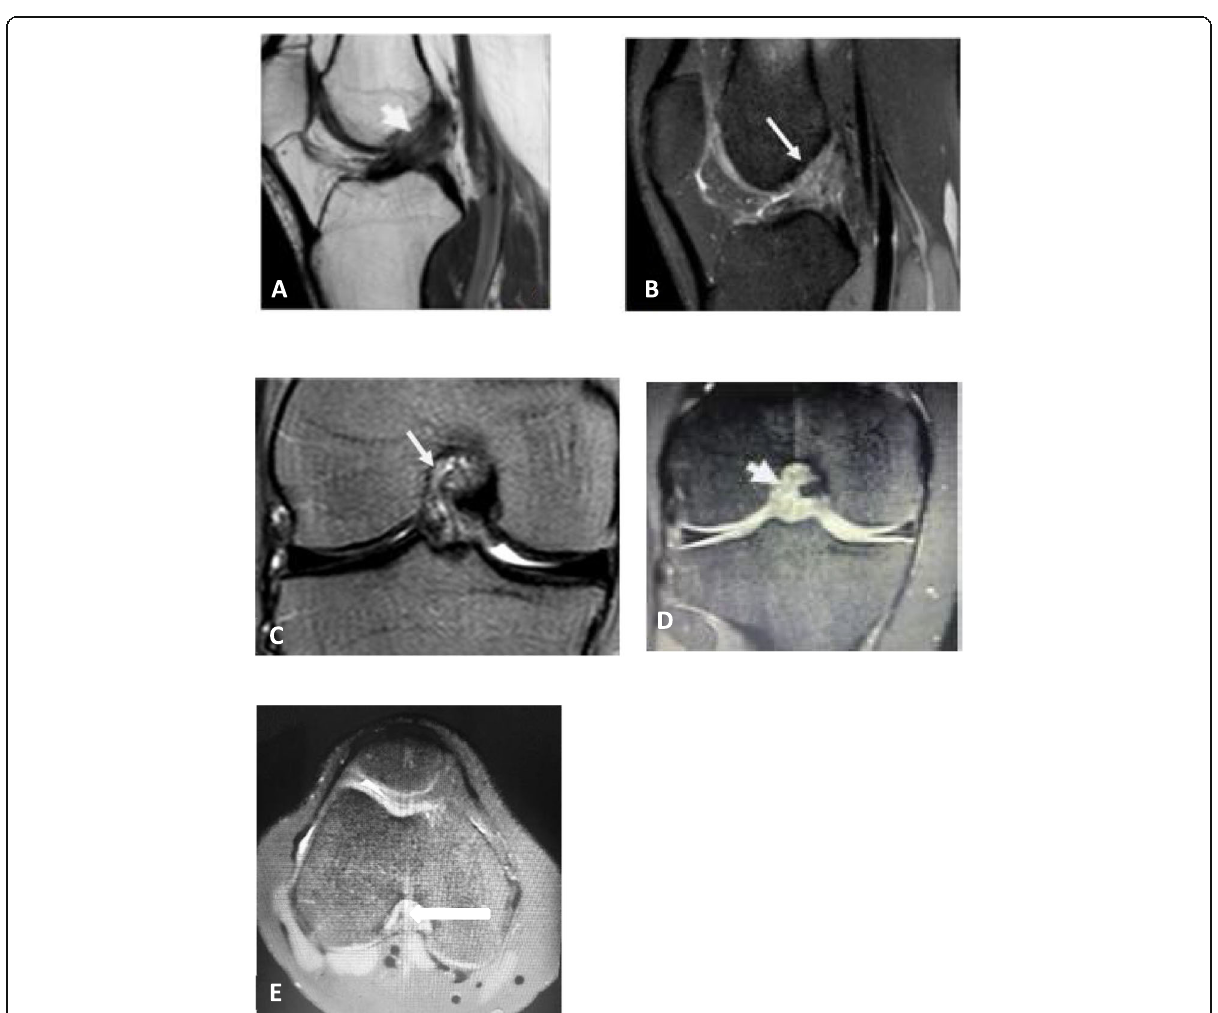
Fig. 6 A 19-year-old male patient presented by acute RT knee joint pain after trauma. a , b Sagittal Standard 2D T2WI and 3D MPR VISTA images. c , b Coronal standard 2D T2 and 3D MPR VISTA images. e Axial MPR VISTA show high-grade partial ACL tear (white arrows)